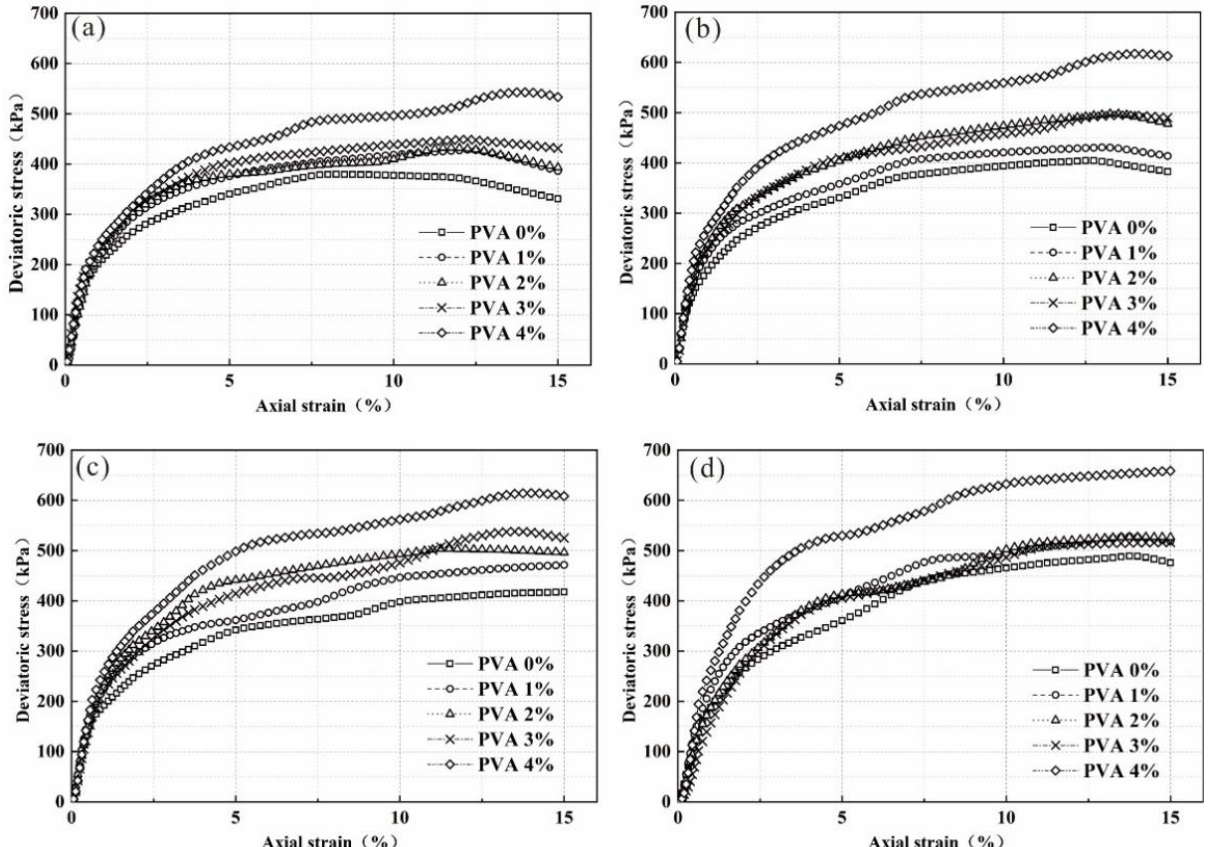
Figure 4. Deviator stress–strain curve with a curing time of 14 days under a confining stress of: ( a ) 50kPa; ( b ) 100 kPa; ( c ) 150 kPa; ( d ) 200 kPa.